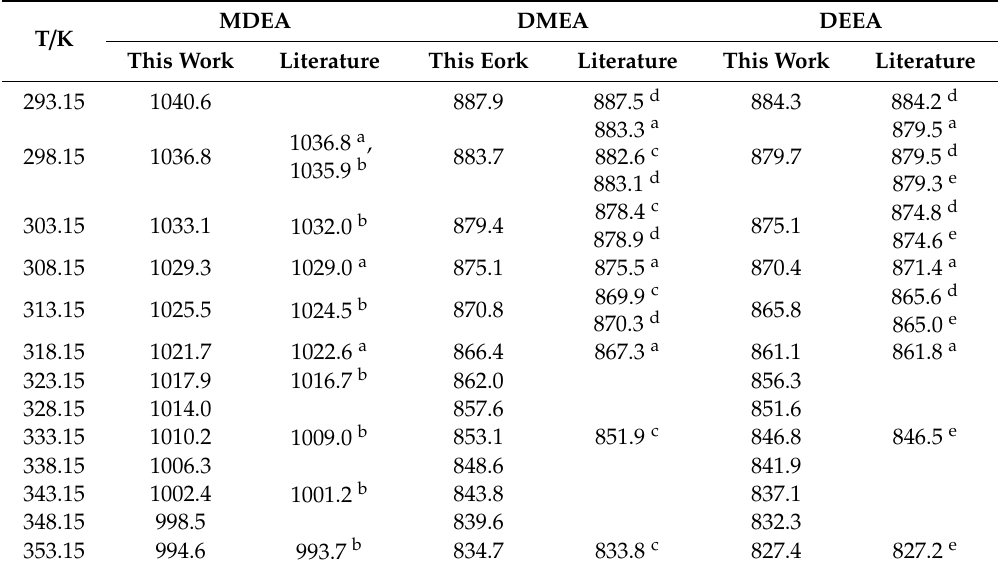
Table 3. Measured density ( ρ / kg · m − 3 ) of pure amines MDEA, DMEA, and DEEA. MDEA DMEA DEEA T / K This Work Literature This Eork